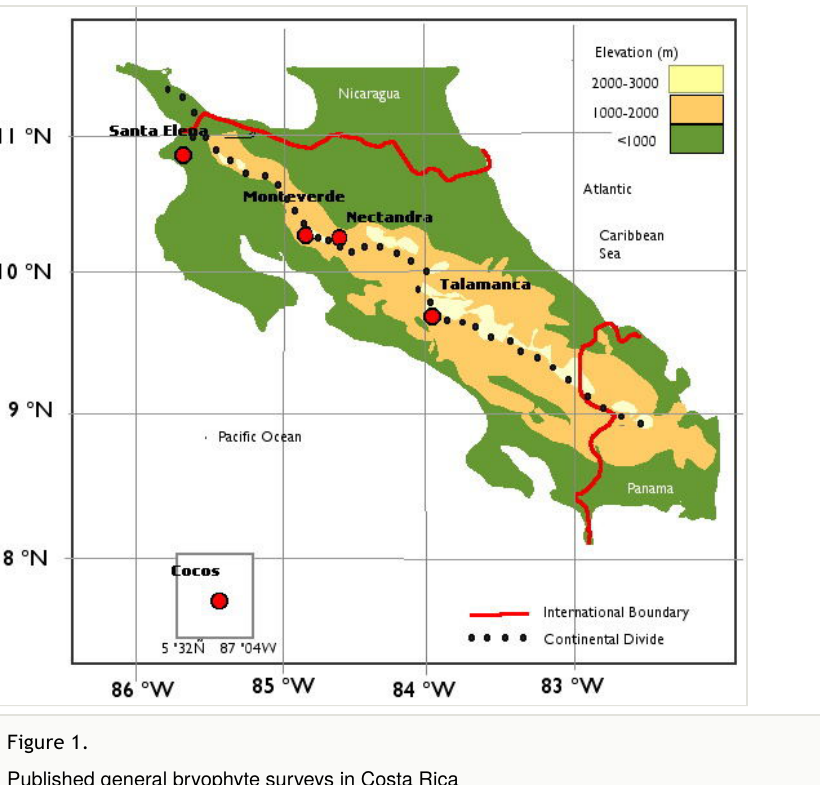
Figure 1. Published general bryophyte surveys in Costa